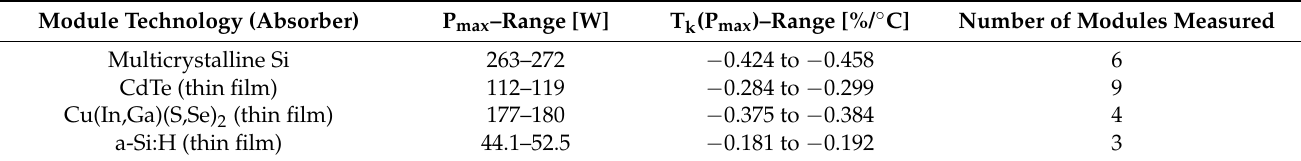
Table 1. Summary of measured PV module properties (this study).